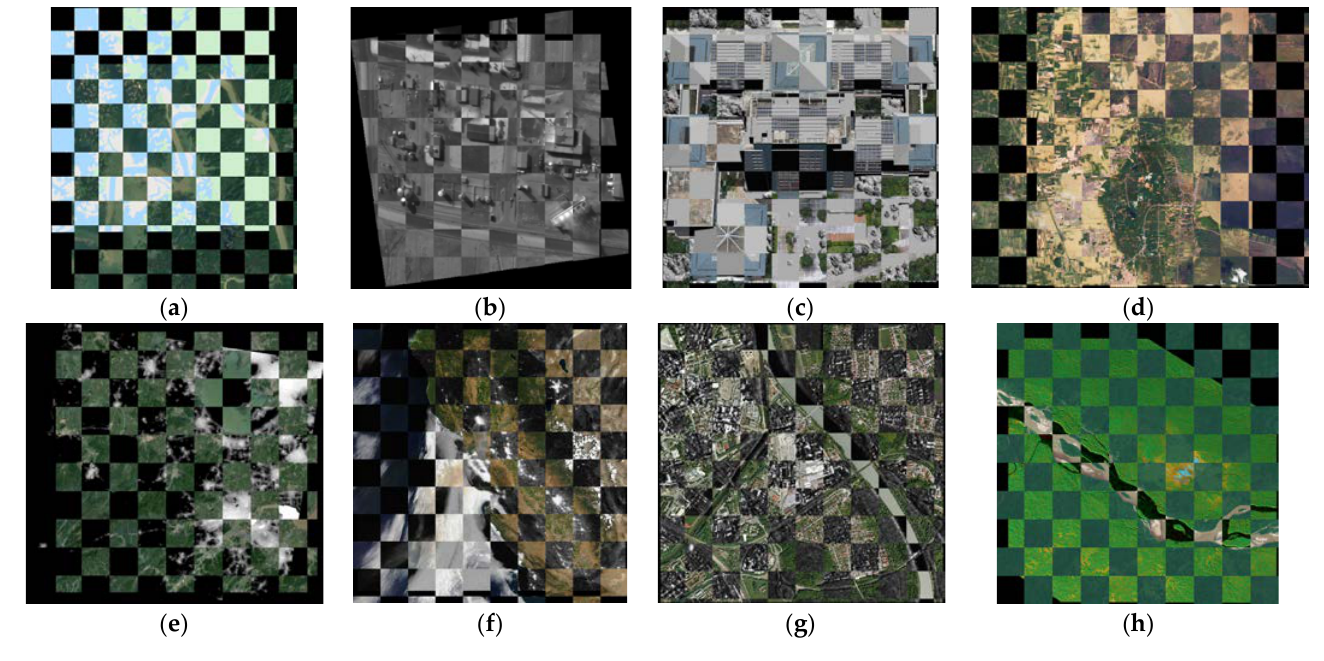
(cid:1) ; ( b ) optical–infrared 2